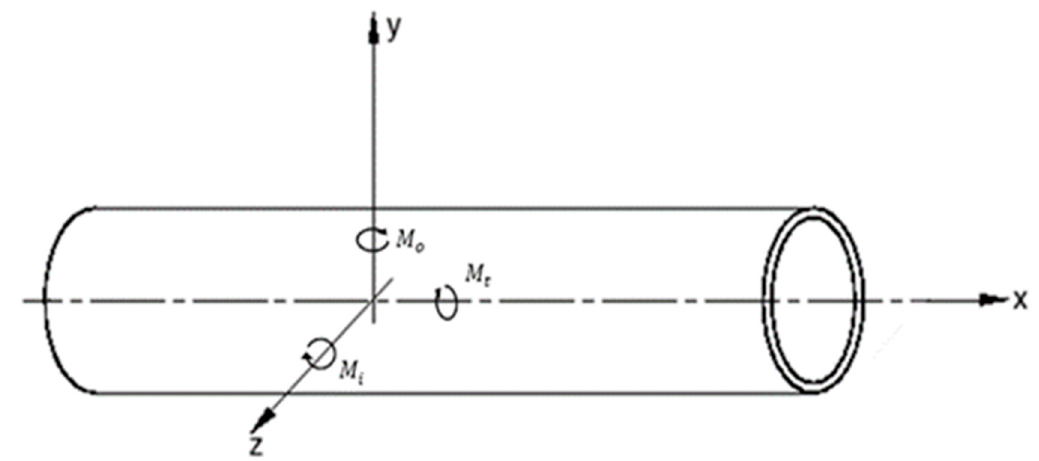
Figure 1. Bending moments in pipes (American Society of Mechanical Engineers (ASME), 2014) [3].